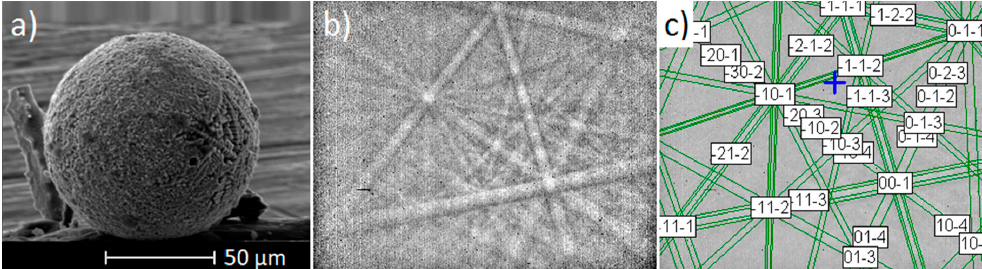
Figure 2. Electron backscatter diffraction (EBSD) measurements of the particle samples: ( a ) morphology of the selected particle, ( b ) electron backscatter diffraction patterns, ( c ) EBSD pattern indexed to the magnetite structure.